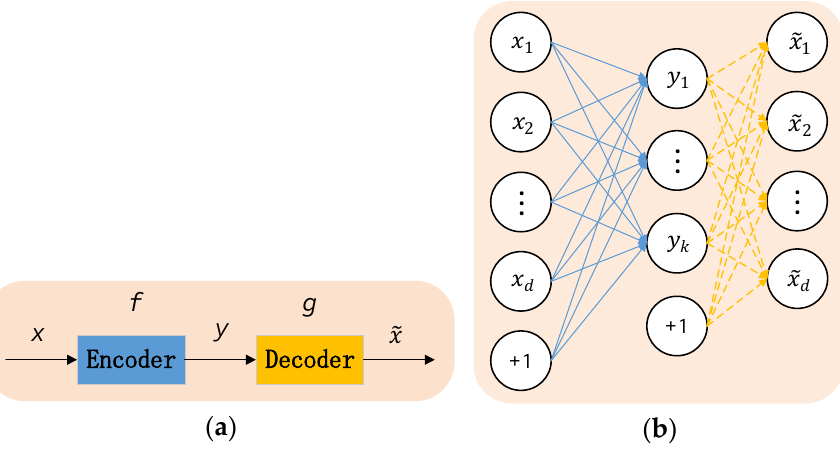
Figure 2. AE structure. ( a ) Block diagram. ( b ) Unfolding structure.